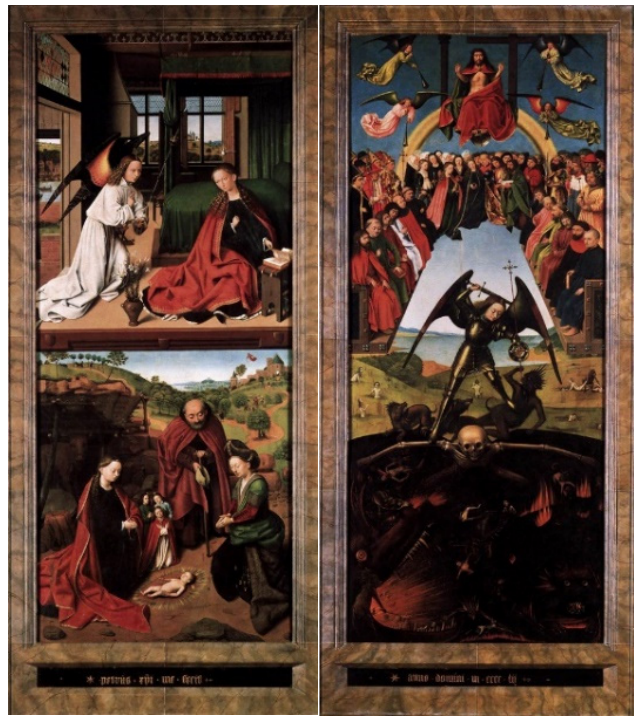
Figure 13. Petrus Christus, Annunciation and Nativity and Last Judgment, 1452, Berlin, Gemäldega-